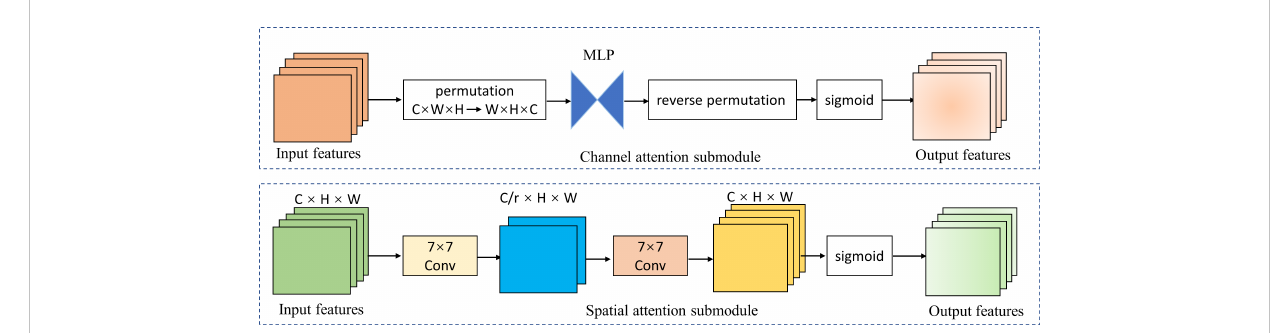
FIGURE 4 Channel attention and spatial attention submodule. MPL represents multi-layer perceptron; r represents reduction ratio; W, H, and C represent the feature map ’ s width, height, and number of